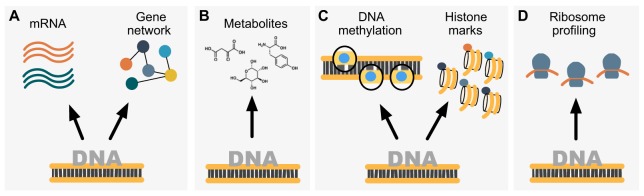
Linking genotypes to cellular-level phenotypes in the rat. (A) Many integrative genomics studies link gene expression (the transcriptome) to the genome (DNA sequence). All the examples discussed in the main text link gene expression to SNP markers, except in Guryev et al. (2008), in which gene expression is linked to CNVs. Studies linking mRNA levels to the genome in a single tissue include Monti et al. (2008), Petretto et al. (2008), Pravenec et al. (2008), Jirout et al. (2010), Low et al. (2013) and Thessen Hedreul et al. (2013), and across different tissues include Hubner et al. (2005) and Langley et al. (2013). Gene regulatory networks can also be linked to the genome (exemplified by Lindblom et al., 2014; Saba et al., 2015; Wang et al., 2015). (B) Metabolite levels, or the metabolome, can also be linked to the genome (exemplified by Dumas et al., 2007). (C) Epigenetic marks, including DNA-methylation levels (exemplified by Johnson et al., 2014) and histone marks (exemplified by Rintisch et al., 2014), can also be linked to the genome. (D) The ribosome profile, or translatome, can also be linked to the genome (as in Schafer et al., 2015).